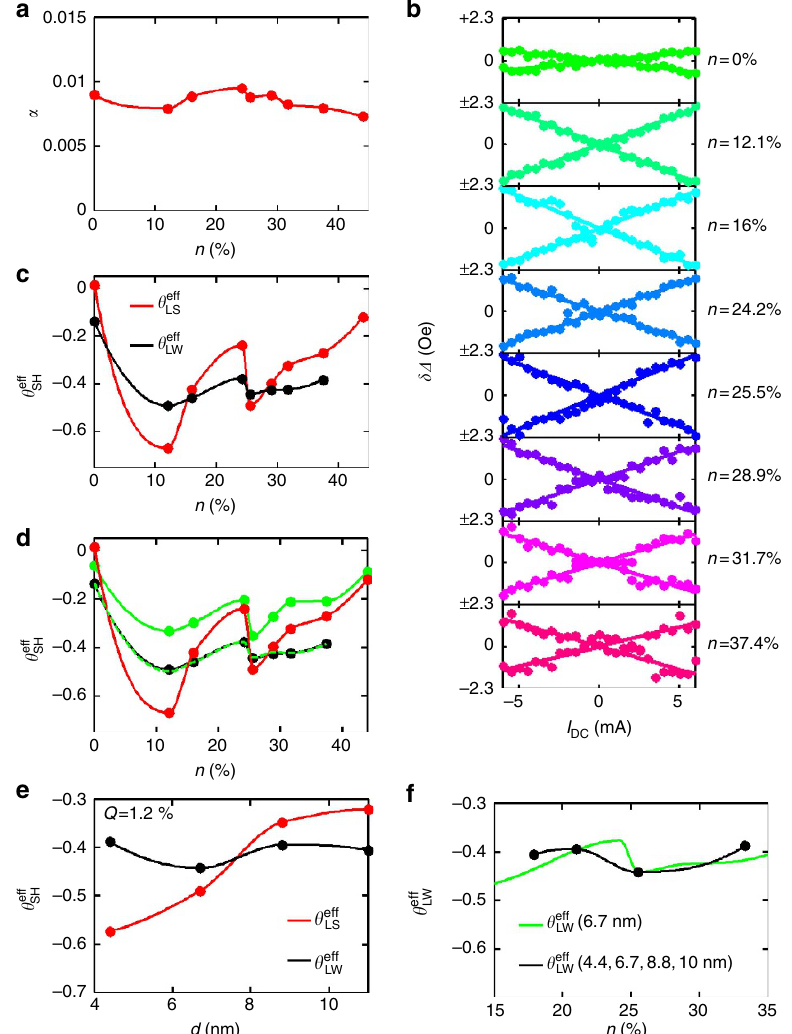
Figure 3 | Line-width analysis. ( a ) Dependence of the Gilbert damping on n . ( b ) Change of linewidth ( d D ) versus d.c. current I d.c. for different n . (cid:2) (cid:3) versus n (black curve) calculated from d.c.-current-dependent linewidth. y eff ( c ) Damping-like spin Hall angle y eff LW purposes. ( d ) Correction of y eff (red) with the RF current measured with a network analyser (green curve, y eff LS slightly adjusted RF current (dashed green curve, y eff I rf ; tot ¼ adjusted (cid:2) (cid:3) ) to match the black curve y eff corr